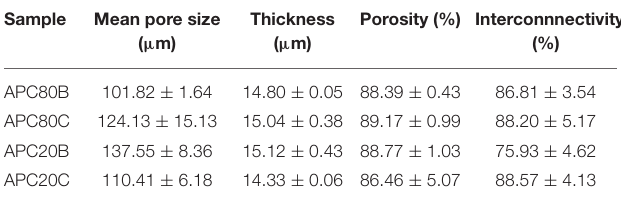
TABLE 2 | Microstructural features of the APC-based sponges obtained by micro-CT. Sample